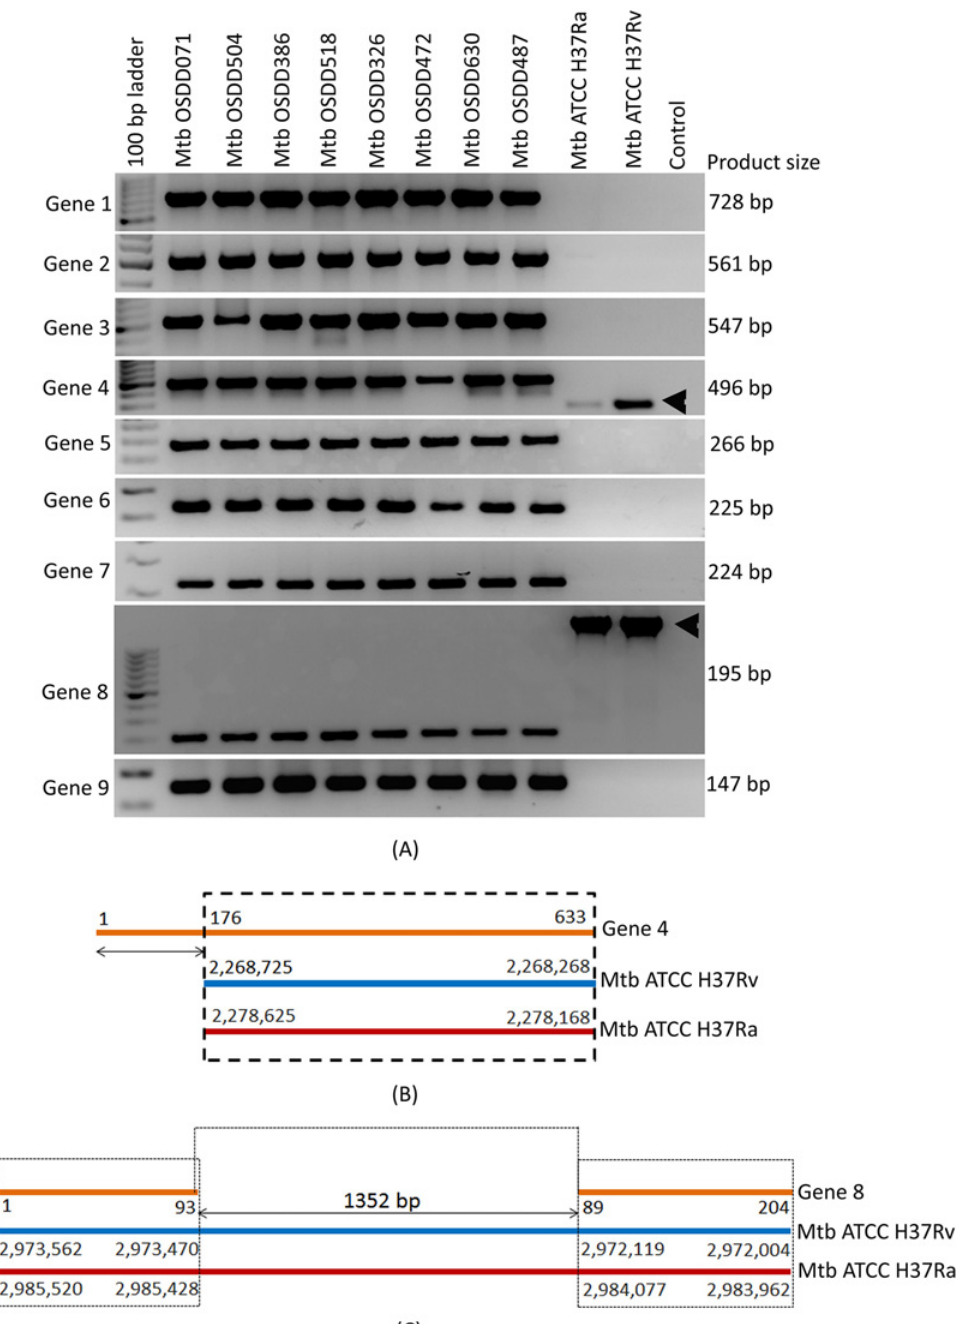
Fig 8. (A) PCR validation of the 10 candidate genes (subset of 74 clusters identified) in 8 Indian clinical isolates (OSDD strains) and reference strains ATCC H37Ra and ATCC H37Rv. Arrow heads indicate the variably sized products in ATCC H37Ra and ATCC H37Rv genomes. Gene 4 and Gene 8 shares partial homology with laboratory strains and showed the presence of a differently sized product in ATCC H37Rv and ATCC H37Ra. (B) The alignment of Gene 4 against reference genomes showed an insertion of 175bp sequence in Gene 4 of OSDD strains with respect to reference strains. (C) The alignment of Gene 8 against reference genomes showed a deletion of 1,352bp sequence in Gene 8 of OSDD strains.